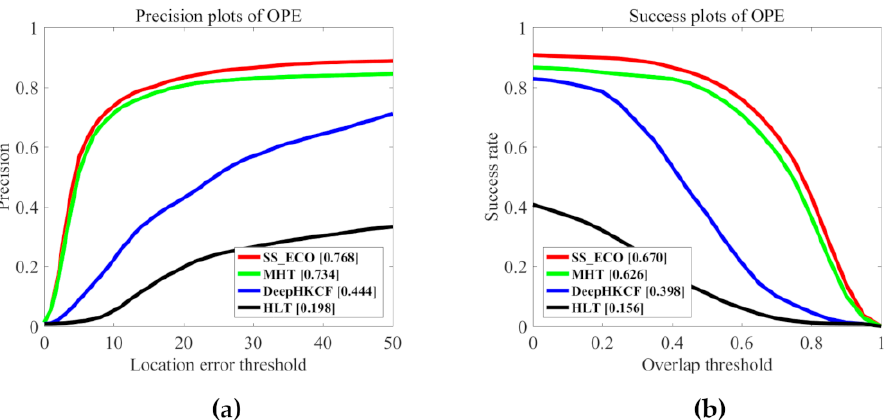
Figure 18. Comparison results with hyperspectral trackers. ( a ) Precision plot. ( b ) Success plot. The legend of the precision plot and success plot report the precision scores at a threshold of 20 pixels and area-under-the-curve (AUC) scores, respectively.